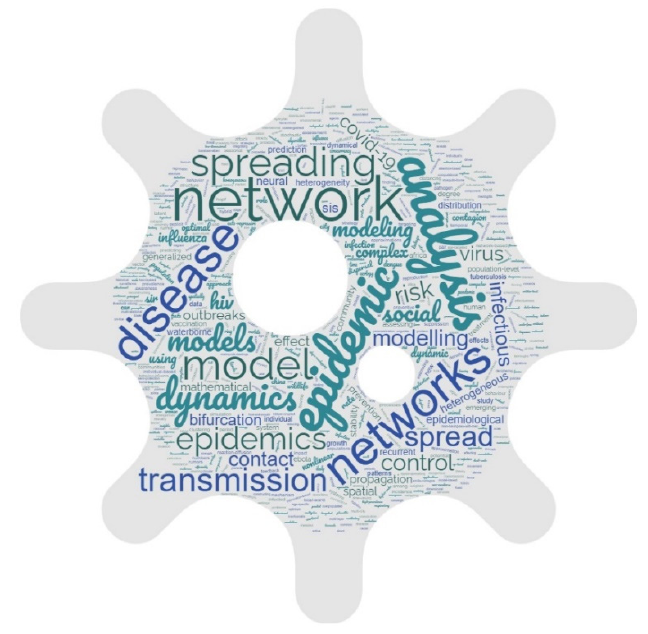
Figure 1. Keyword